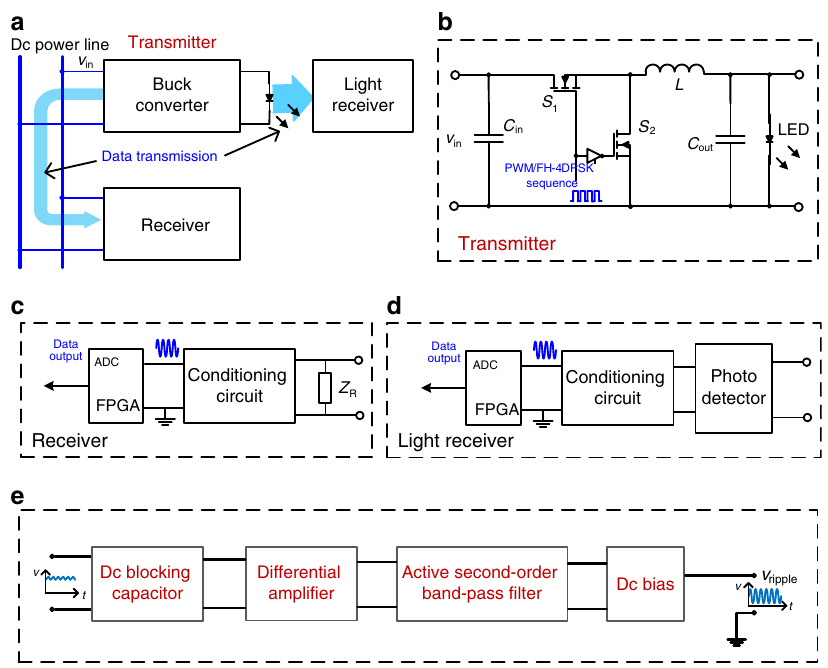
Fig. 9 Structure of the prototype LED lighting system. In this experiment, PWM/FH-4DPSK modulation are employed. a The general structure of the